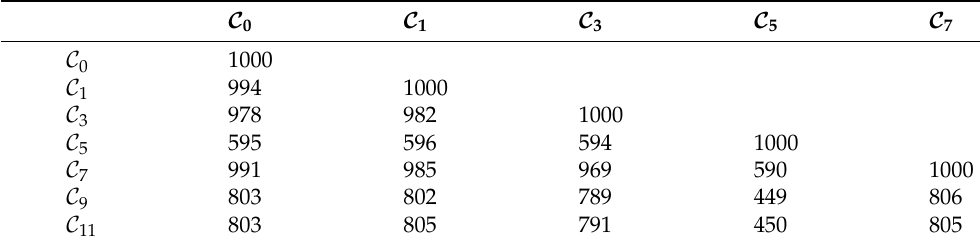
Table 7. Cardinality of the intersection of the top 1000 posts for each possible pair of weight